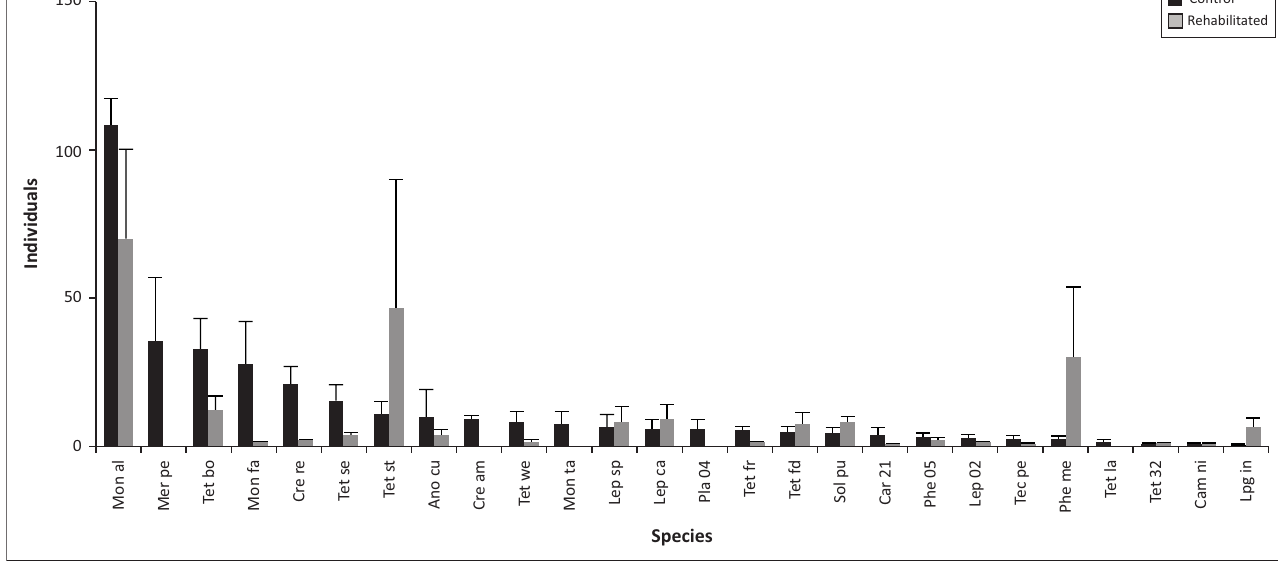
FIGURE 4: Rank abundance plot for the rehabilitated and control grassland sites on Rietvlei Nature